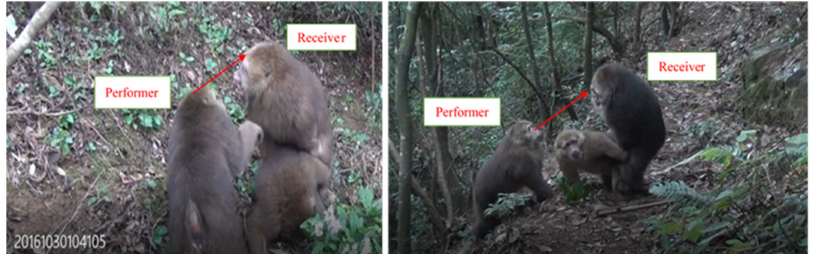
Figure 1. Sexual interference behaviors in Tibetan macaques ( Macaca thibetana, performer refers to individuals performing interference; receiver refers to individuals interfered by